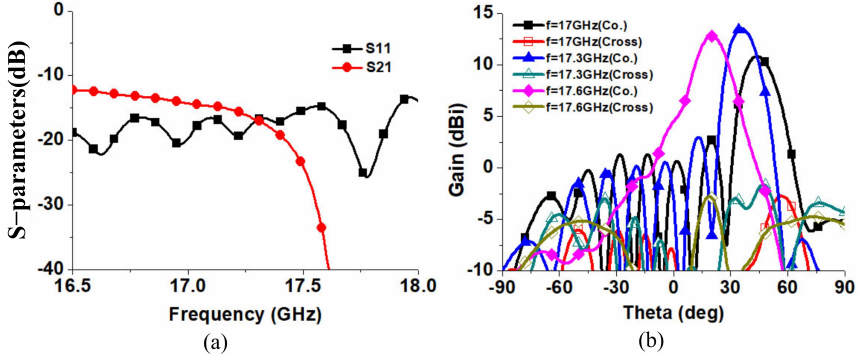
Figure 8. ( a ) The S–parameters of the − 45 ◦ LP antenna, and ( b ) simulated gain for the − 45 ◦ LP antenna in the E–plane at the 17 GHz, 17.3 GHz, and 17.6 GHz,